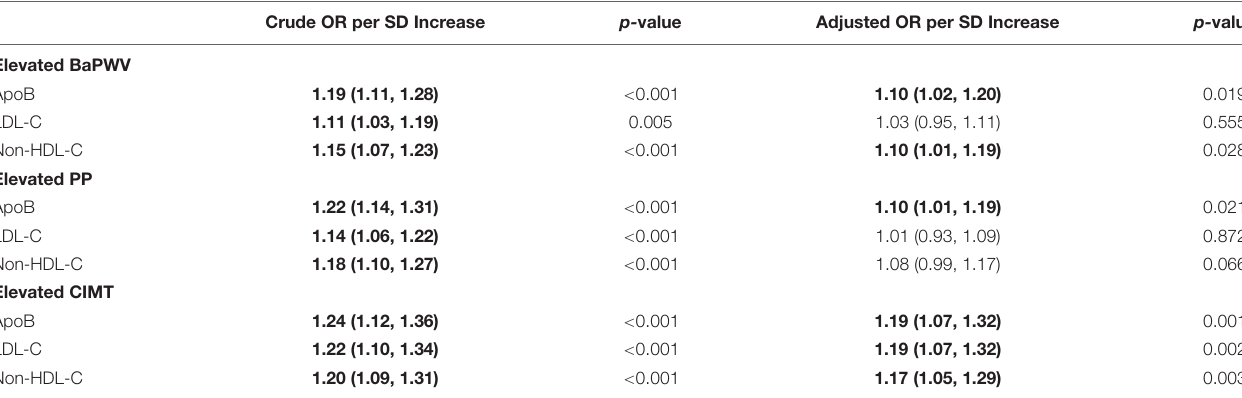
TABLE 2 | Multivariable-adjusted odds ratios of elevated baPWV , PP , and CIMT according to per SD increase in concentrations of apoB, LDL-C, and non-HDL-C. Crude OR per SD Increase p- value Adjusted OR per SD Increase p-